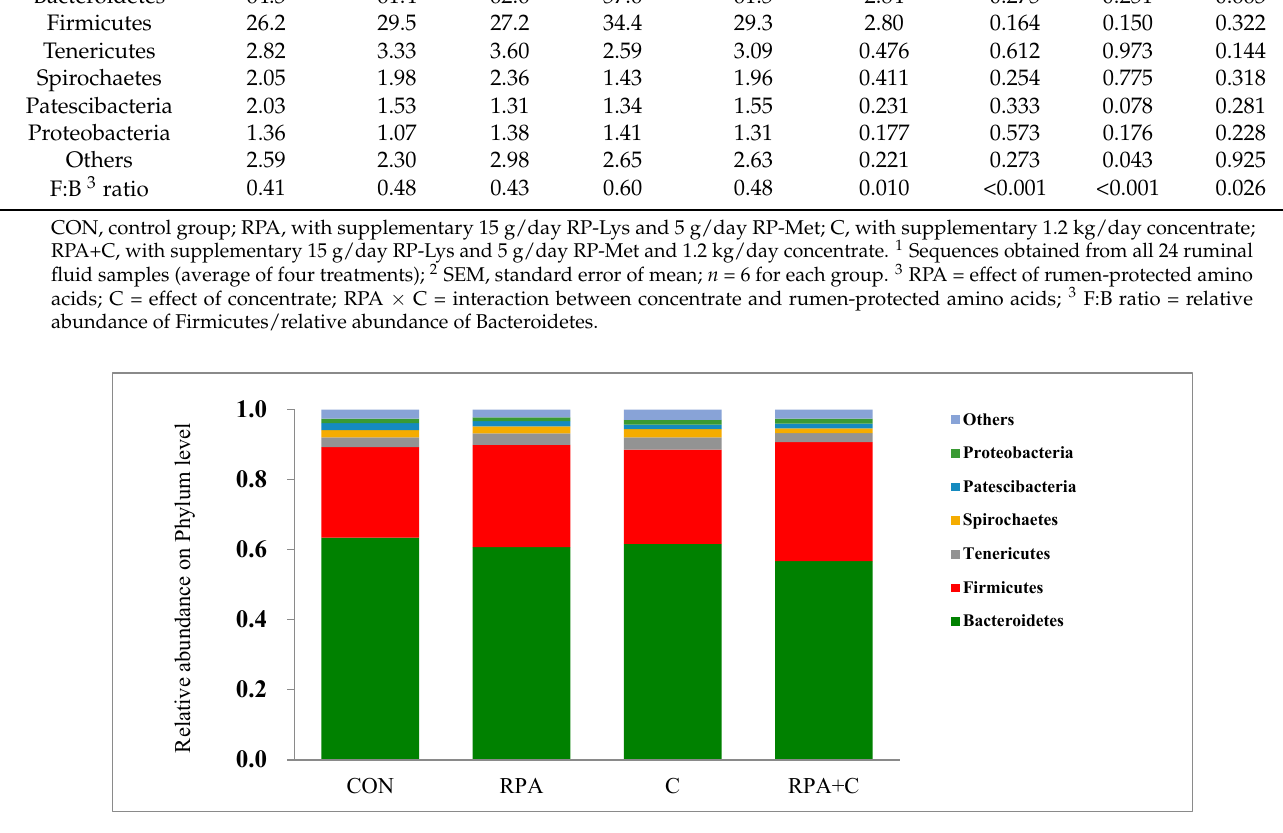
Figure 3. Phylum-level average relative abundances (percentage of total reads) of grazing, lactating yaks offered supple- mentary 15 g/day RP-Lys and 5 g/day RP-Met (RPA), 1.2 kg/day concentrate (C) and 15 g/day RP-Lys, 5 g/day RP-Met and 1.2 kg/day concentrate (RPA+C), or no supplements (control-CON).